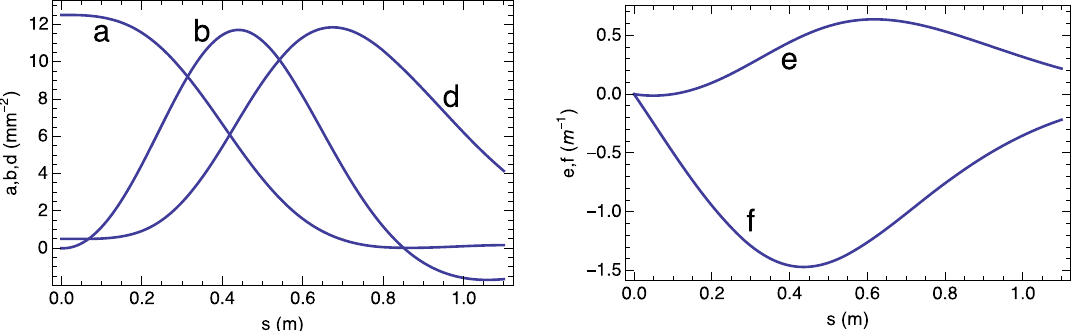
FIG. 1. Plot of the functions a ð s Þ , b ð s Þ , d ð s Þ (left panel) and e ð s Þ , f ð s Þ (right panel). Note that the first three functions have dimension of the inverse length squared and are measured in mm − 2 , while the last two have the dimension of the inverse length and are measured in m − 1 . The arc length s is measured from the entrance to the magnet.